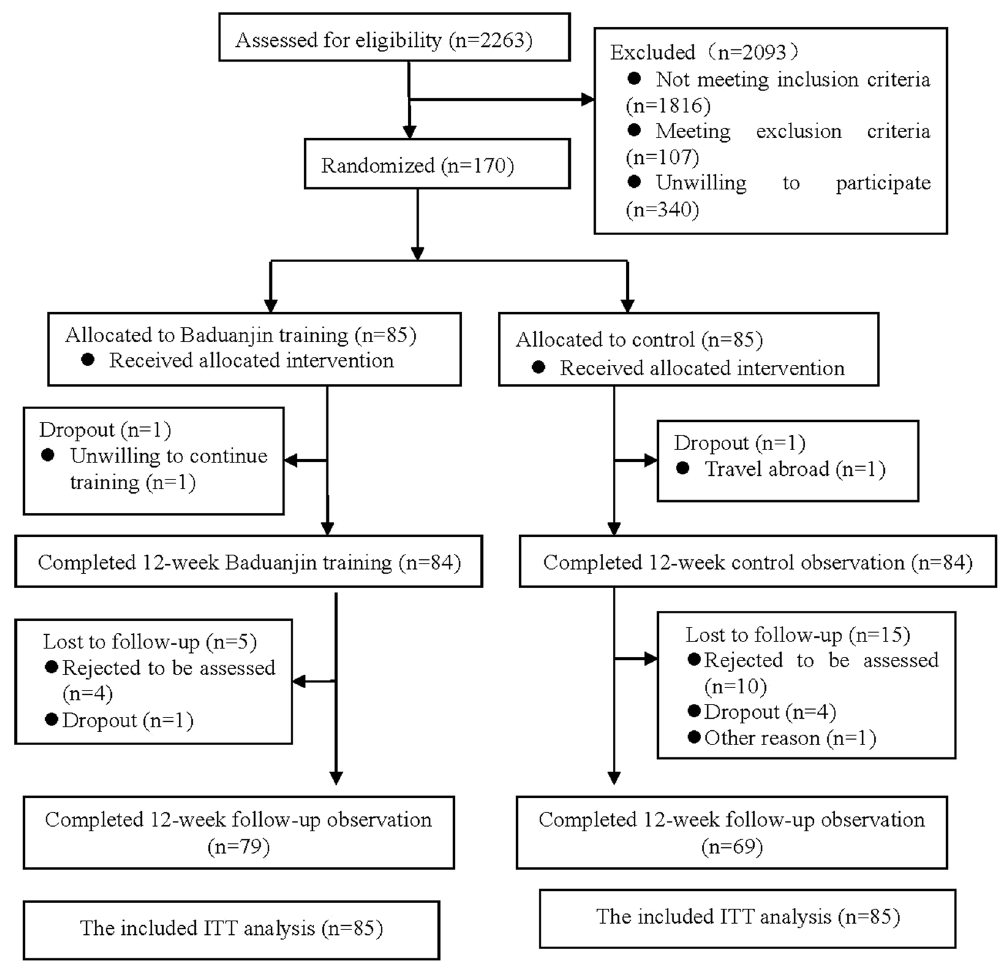
Figure 1. Participants flow through the study reported in a CONSORT